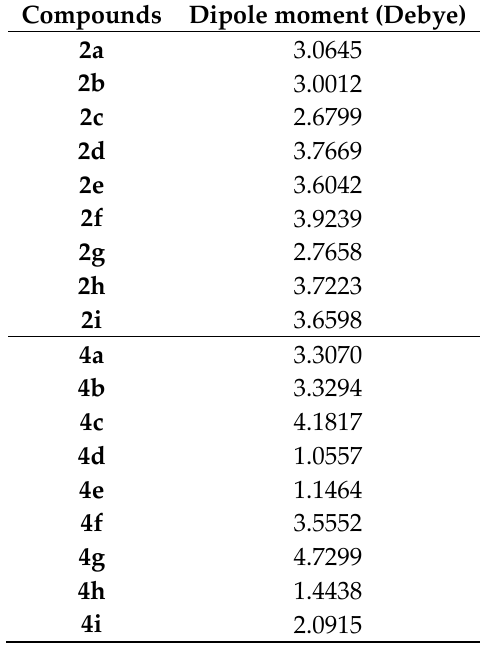
Table 4. The values of dipole moment (Debye) for the newly synthesized pyridine derivatives viz . 2a – 2i , 3 , 4a – 4i calculated at B3LYP/6-31G(d,p) level of DFT.